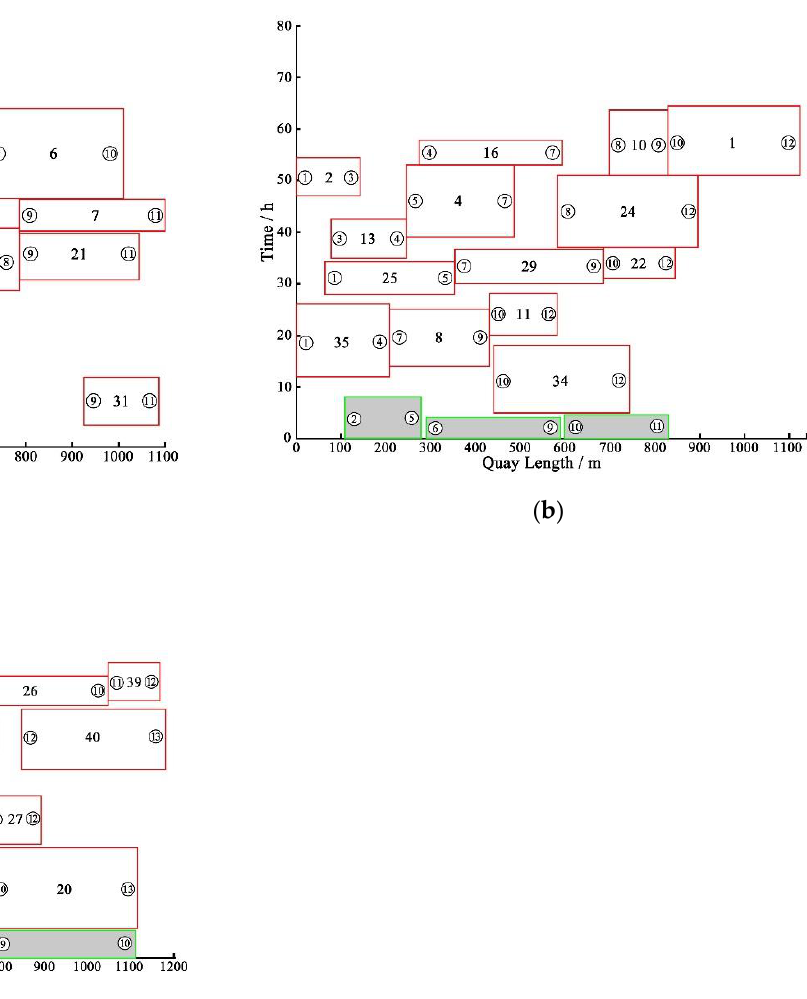
Figure 8. The scheduling solution under S + U. ( a ) terminal 1; ( b ) terminal 2; ( c ) terminal 3. (Source: compiled by authors).